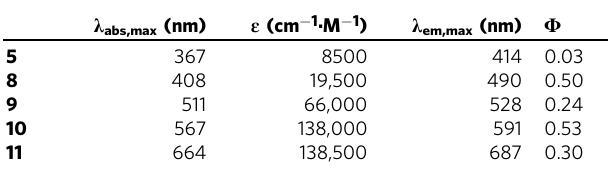
Table 1 Summary of optical properties of Type-III probes 5 and 8 – 11 a